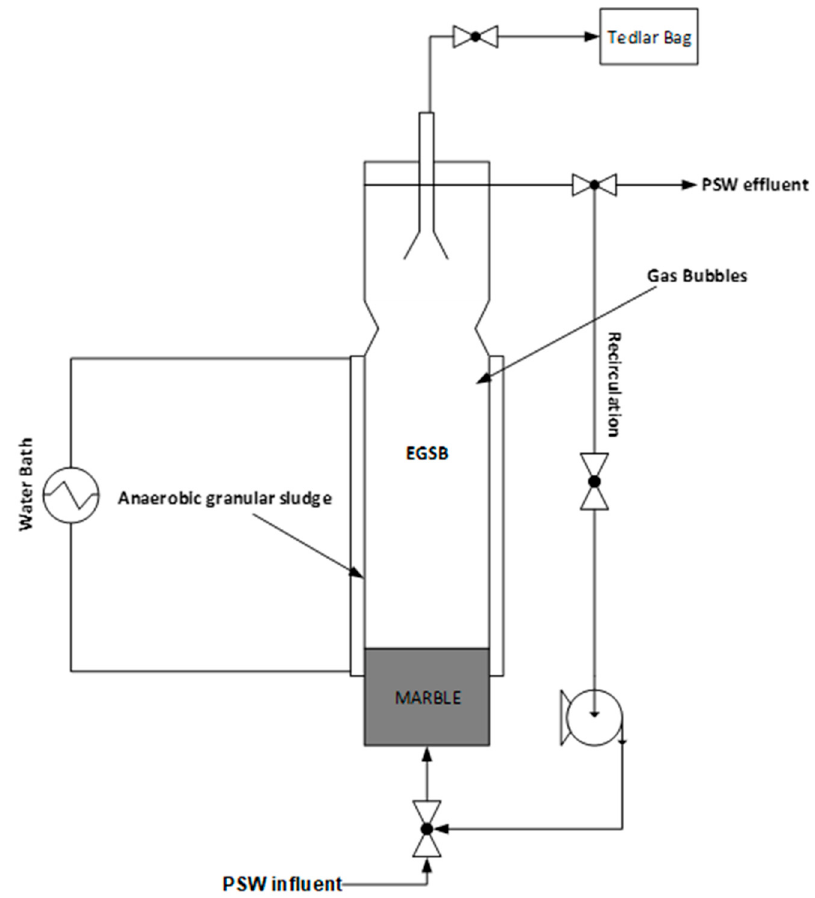
Figure 2. Schematic representation of the EGSB used.